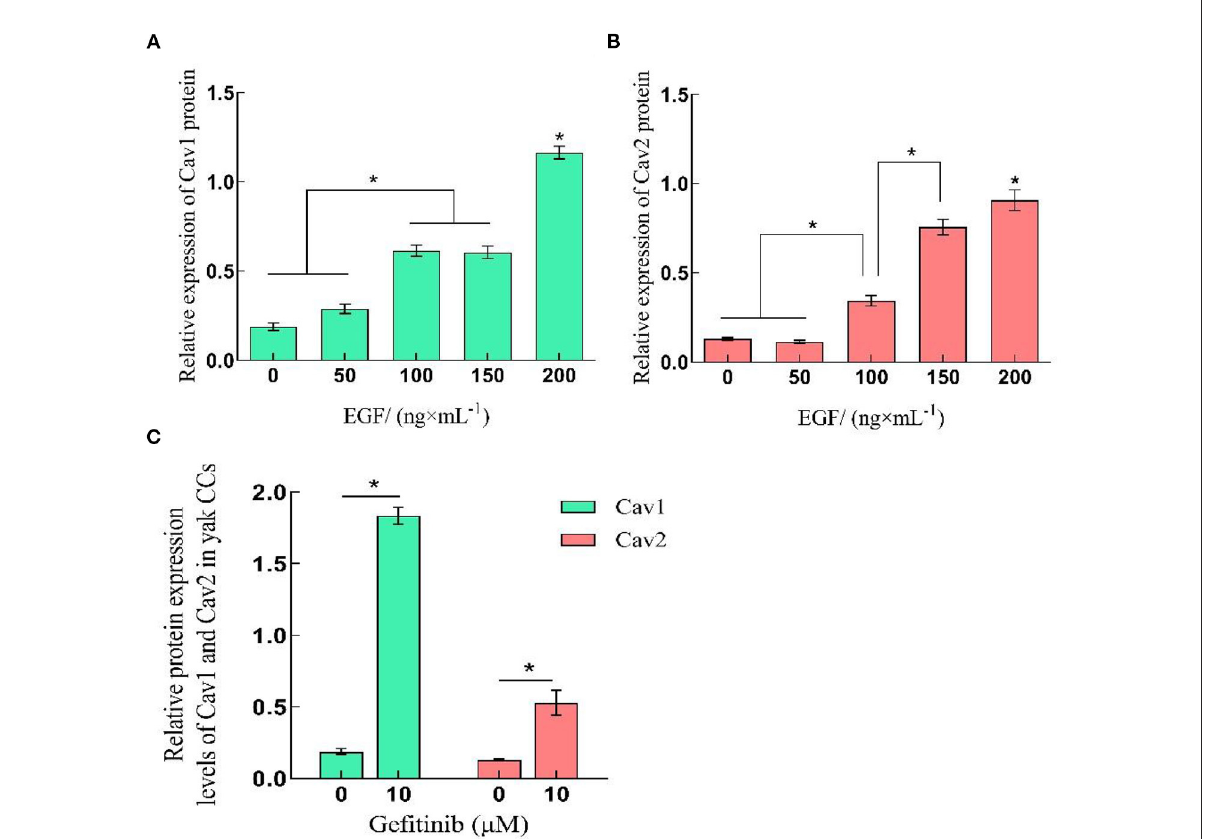
FIGURE6 Relative expression levels of Cav1 and Cav2 protein in yak CCs treated with different concentrations of EGF and the optimal concentration of gefitinib (EGFR inhibitor). (A, B) Relative protein expression levels of Cav1 and Cav2 in yak CCs (EGF group). (C) Relative protein expression levels of Cav1 and Cav2 in yak CCs (Gefitinib group). *on the bars indicates values that differ significantly (* P <